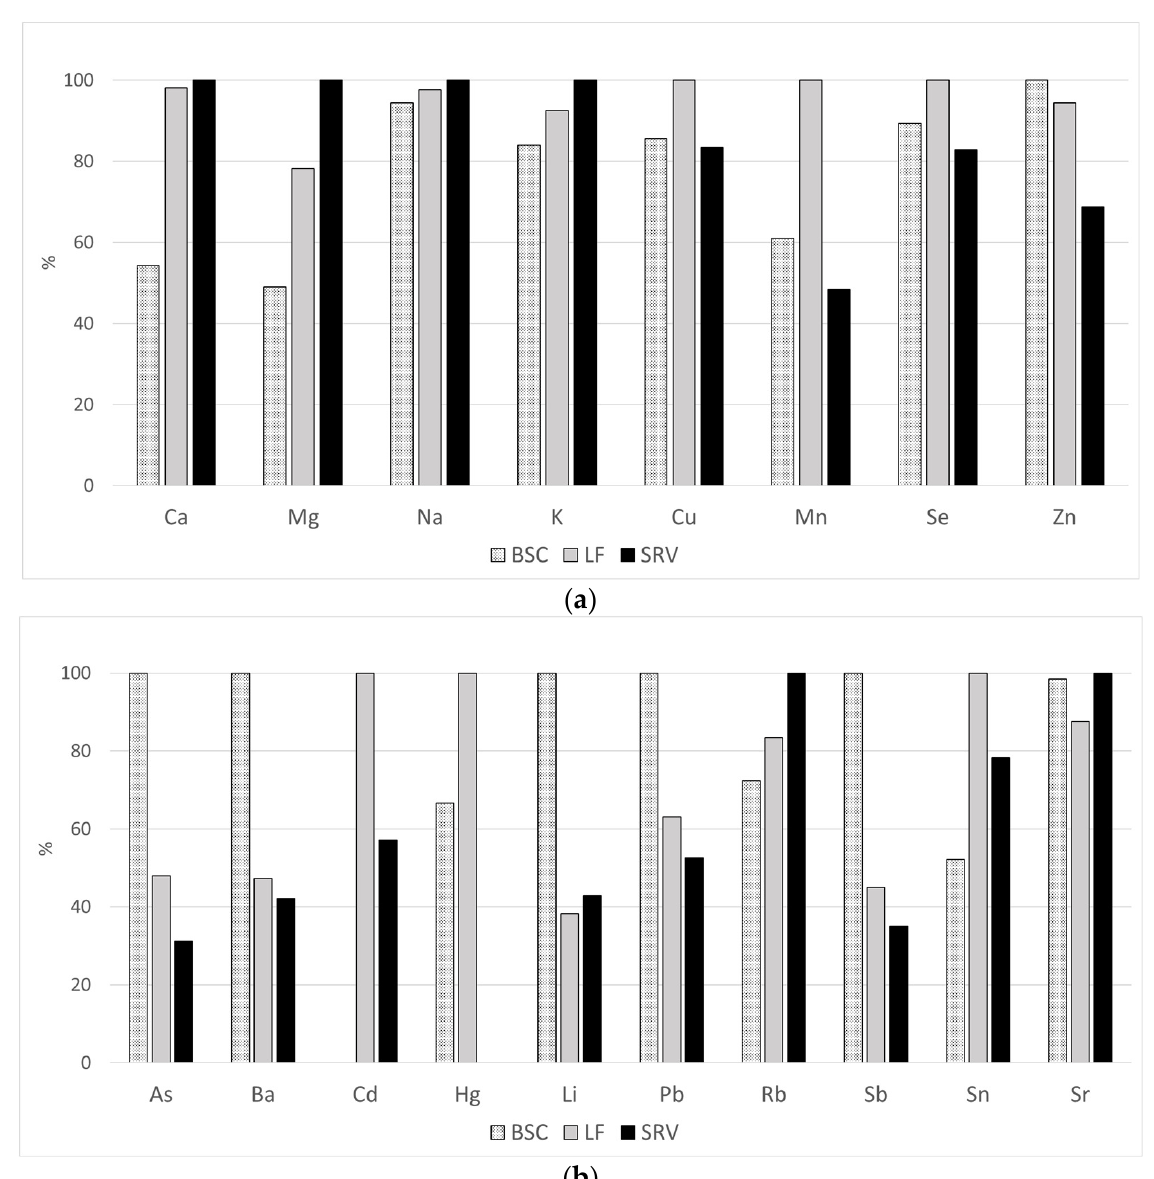
Figure 1. Percentage Elemental Relative Concentrations in blood serum. For each element, the percentage calculated with formula (1) of each group (BSC, LF, SRV) is reported. ( a ) shows the elements defined as macro and essential ones; ( b ) shows the elements defined as additional and non-essential ones.